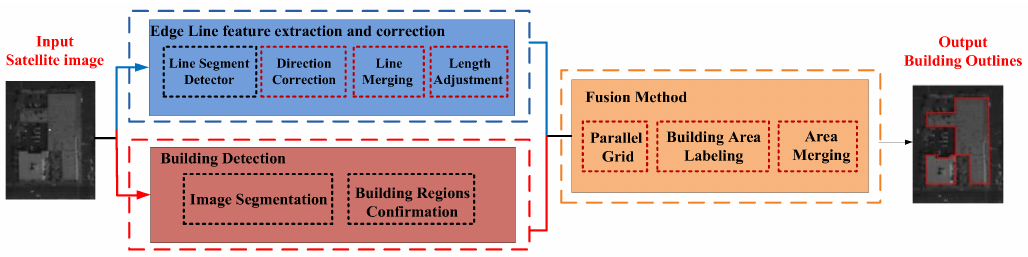
Figure 2. The proposed outline extraction